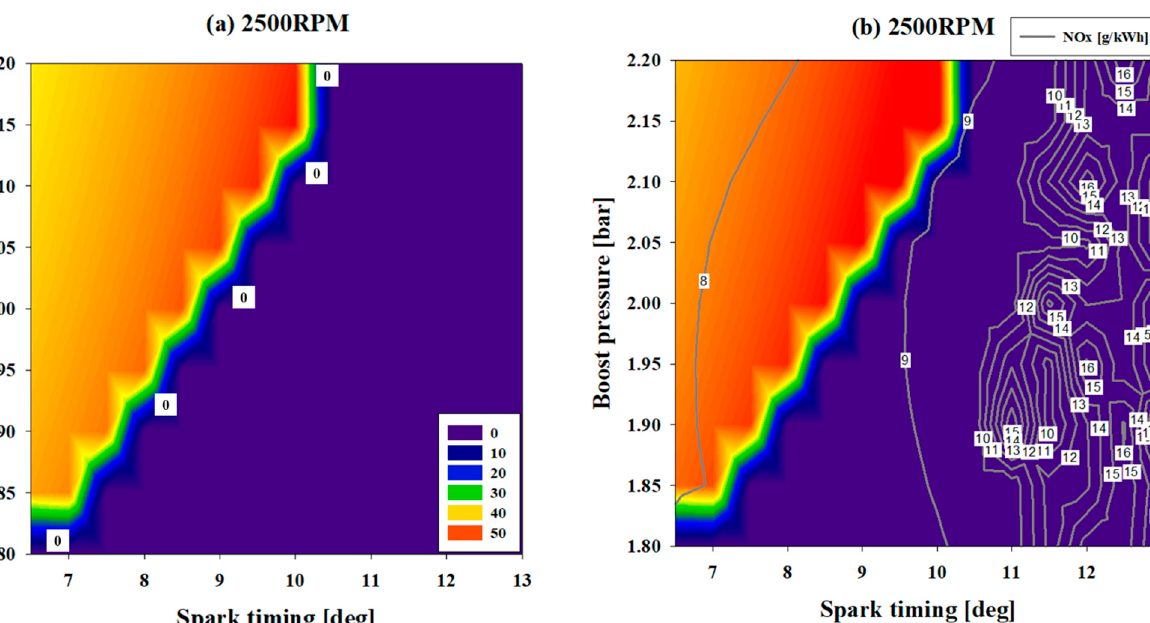
Figure 8. ( a ) Predicting knocking phenomenon according to changes in spark timing and boost pressure.at 1800 RPM. ( b ) Predicting NOx amounts according to changes in spark timing and boost pressure at 1800 RPM. ( c ) Predicting torque tendency according to changes in spark timing and boost pressure at 1800 RPM.